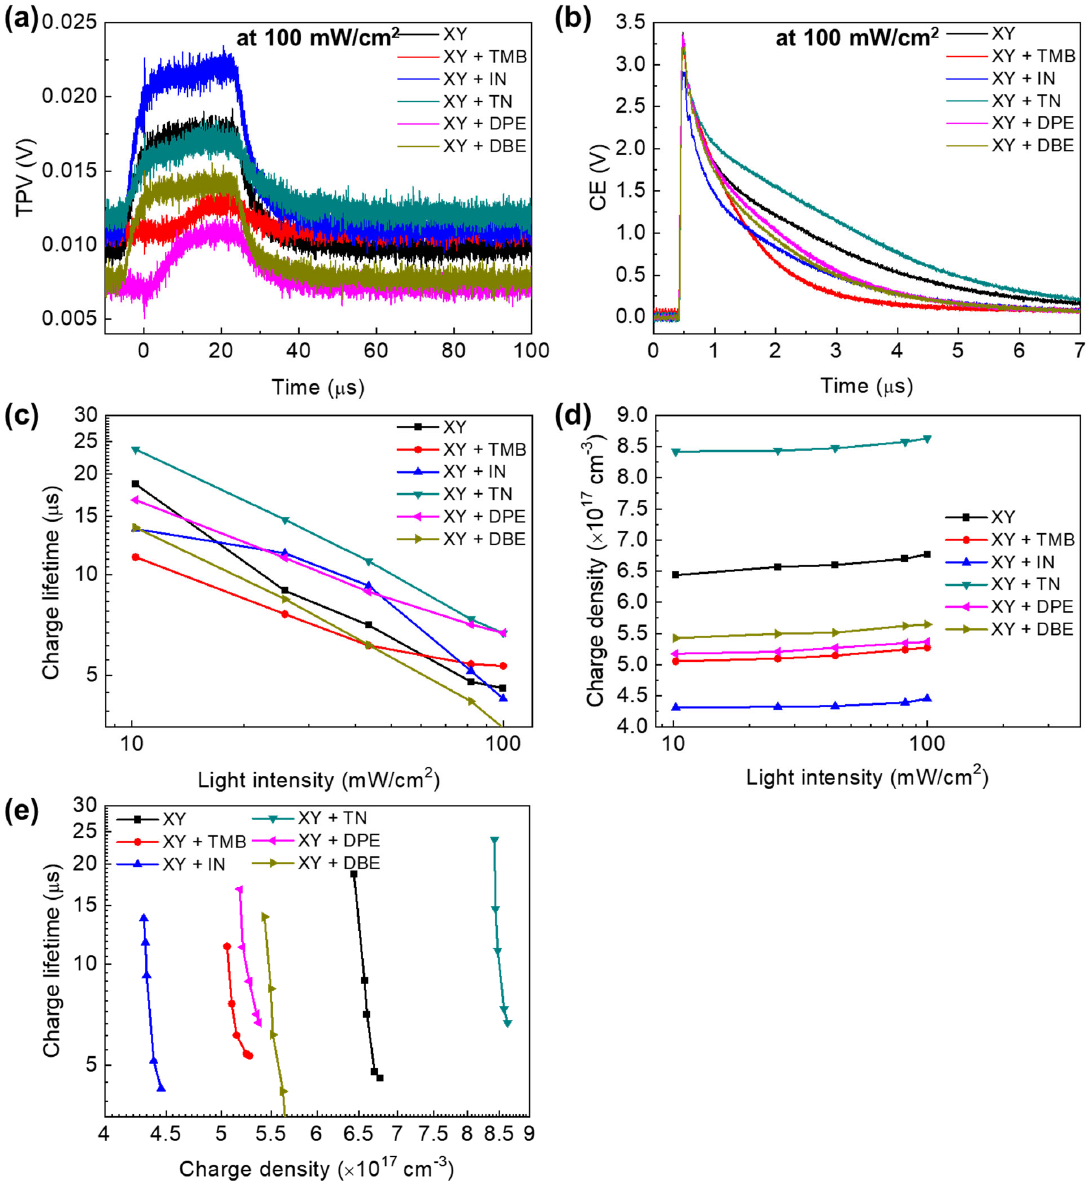
Figure 4. ( a ) TPV profiles measured at 100 mW/cm 2 with a green LED pulse; ( b ) CE curves measured at 100 mW/cm 2 ; ( c ) plot of light intensity versus charge lifetime; ( d ) plot of light intensity versus charge density; ( e ) plot of charge density versus charge lifetime for APSCs depending on the type of processing